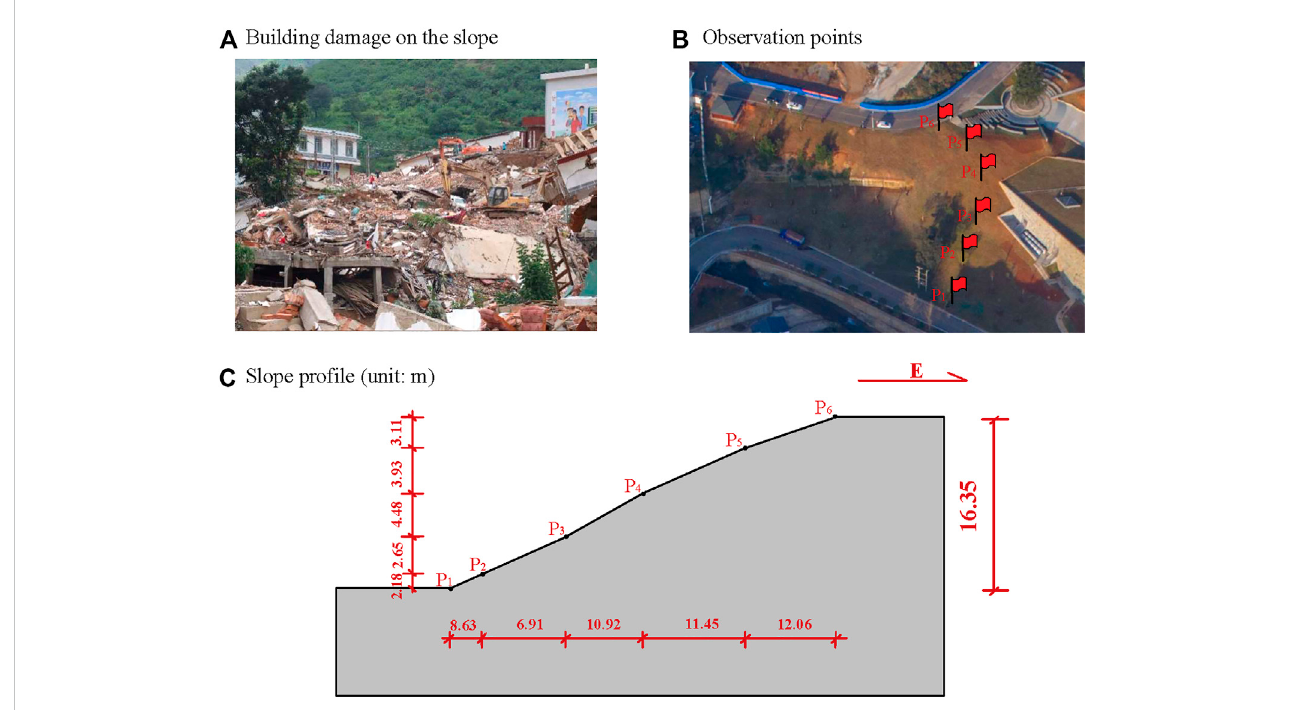
FIGURE 2 Building damage and observation point for ground pulsation on the slope site in Longtoushan Market Town.